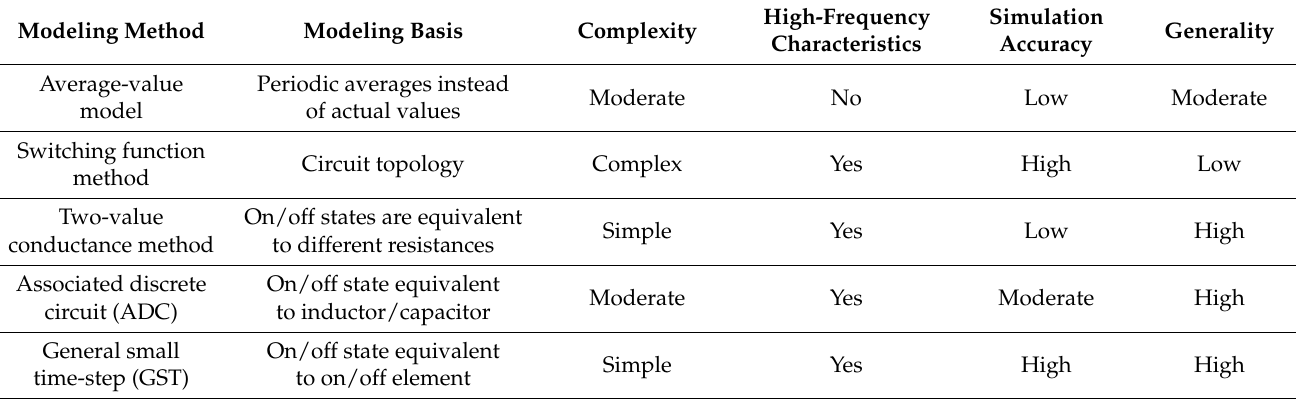
Table 1. Comparison of switching device modeling